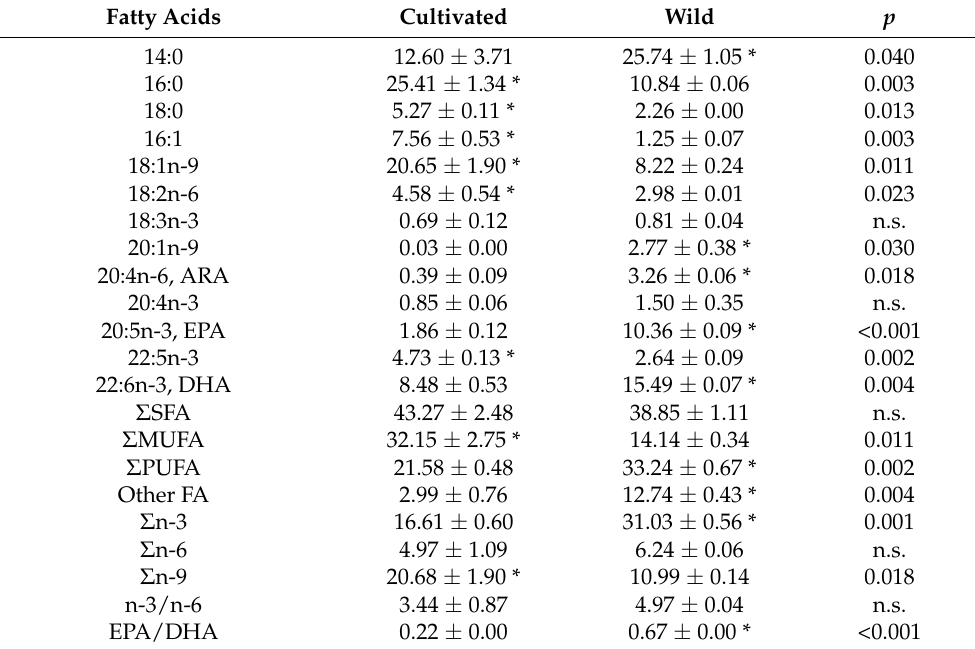
Table 3. Liver fatty acid profile (% of total fatty acids) of wild and cultivated thick-lipped grey mullets. Fatty Acids Cultivated Wild p 12.60 ±